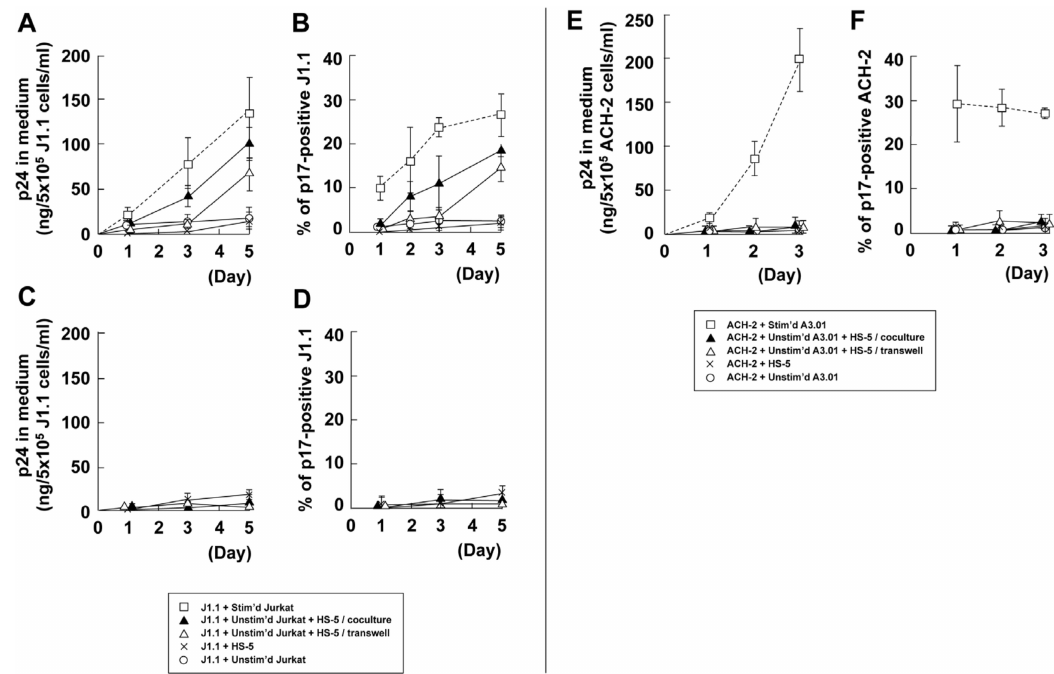
Figure 7. HIV-1 reactivation in the presence of stromal cells. ( A,B ) Coculture of J1.1 cells with unstimulated Jurkat in the presence of live HS-5 stromal cells. HS-5 cells were grown in the lower compartments of transwell plates. J1.1 and unstimulated Jurkat cells were added to the lower compartments (allowing cell-to-cell contact with HS-5 cells) or to the upper compartments (separately from HS-5 cells). ( C,D ) Coculture of J1.1 cells with unstimulated Jurkat in the presence of paraformaldehyde-fixed HS-5 cells. ( A,C ) HIV-1 p24 production to culture medium. The levels of HIV-1 p24 antigens were measured by HIV-1 p24CA antigen capture ELISA. ( B,D ) Reactivation e ffi ciency of HIV-1 in J1.1 cells. J1.1 cells (prelabeled) and unstimulated Jurkat cells were cocultured in the presence of HS-5 cells, and the J1.1–Jurkat cell mixtures were subjected to immunostaining for HIV-1 p17MA. The p17MA-positive rates were calculated as described in Figure 1. Data are the mean ± SD from three independent experiments. For comparison, the data on the J1.1-stimulated Jurkat coculture with cell-to-cell contact (in Figure 1A,H) were shown (dashed lines). ( E,F ) Coculture of ACH-2 cells with unstimulated A3.01 in the presence of live HS-5 stromal cells. HS-5 cells were grown in lower compartments of transwell plates, and ACH-2 and unstimulated A3.01 cells were cocultured with cell contact in the lower compartments or separately in the upper compartments. ( E ) HIV-1 p24 production to culture medium. ( F ) Reactivation e ffi ciency of HIV-1 in ACH-2 cells. The p17MA-positive rates were calculated as described in Figure 2. Data are the mean ± SD from three independent experiments. For comparison, the data on the ACH-2-stimulated A3.01 coculture with cell-to-cell contact (in Figure 2A,H) were shown (dashed